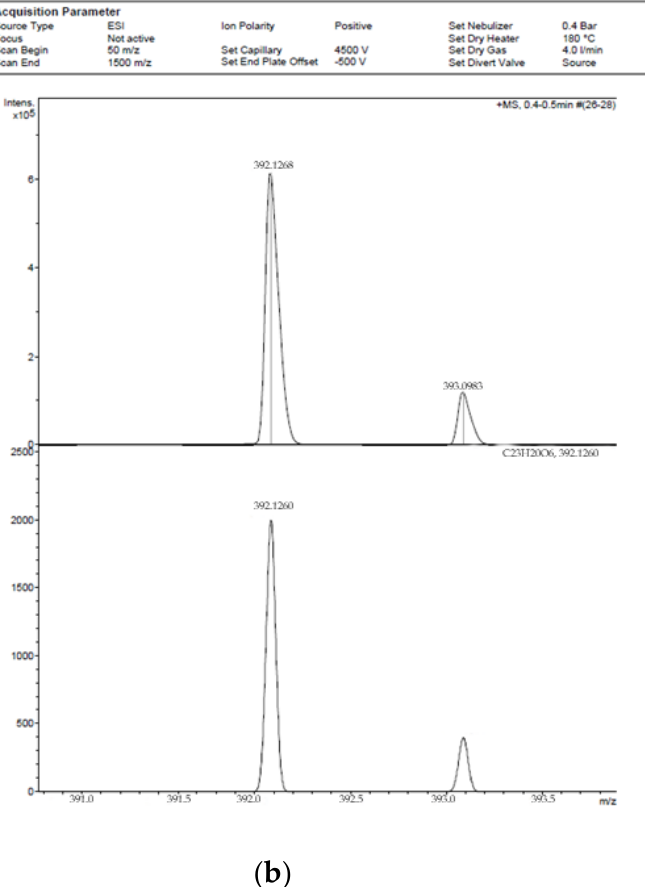
Figure 2. Proton ( 1 H) NMR ( a ) and high-resolution mass spectrometry (HRMS) ( b ) spectrum of 6-C-(1-(4-hydroxyphenyl) ethyl) aromadendrin from extracts of callus, cell suspension, and root cultures of Rhodiola rosea .